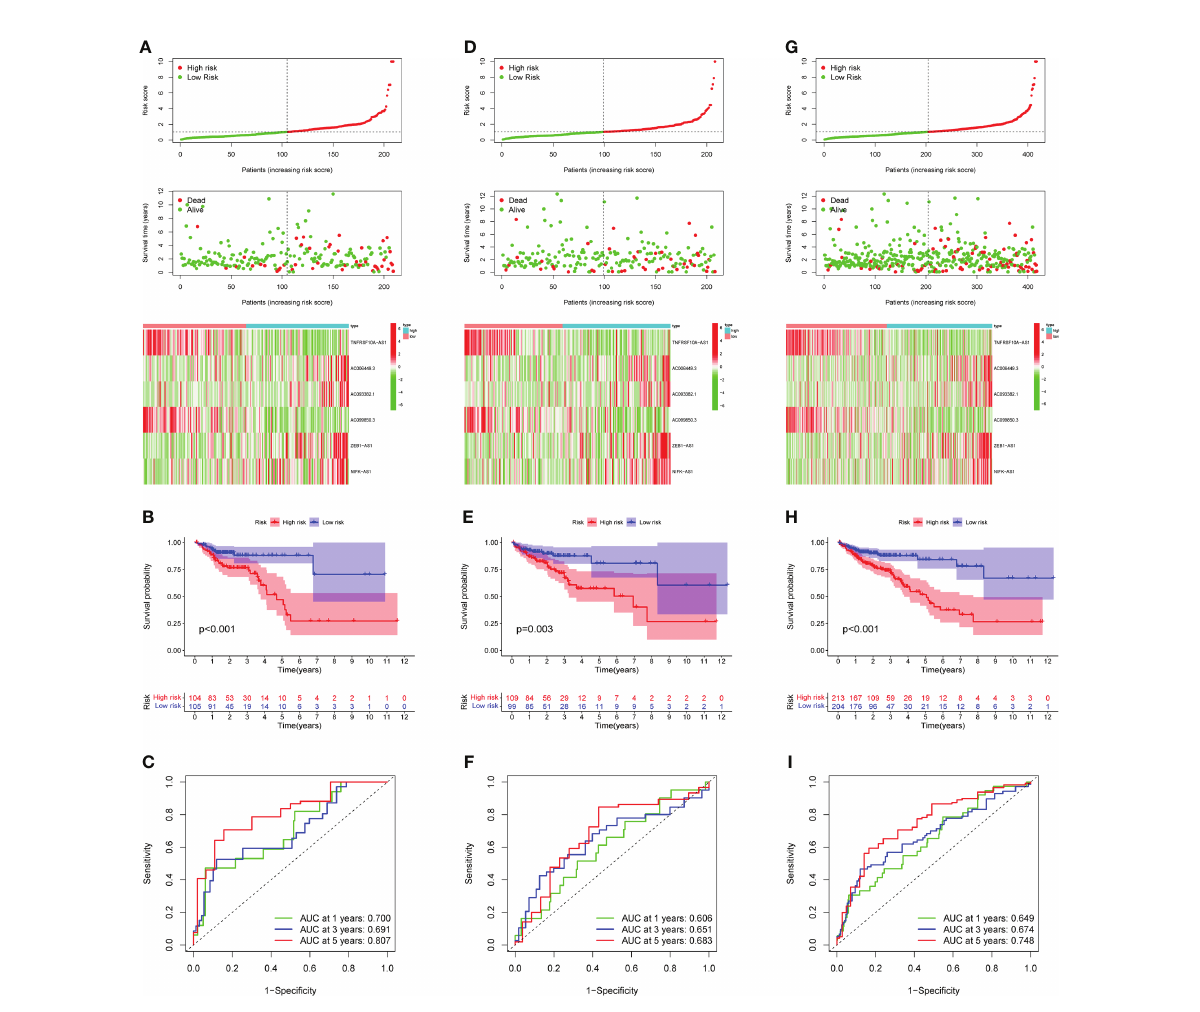
FIGURE 3 Prognostic model construction and evaluation. (A) In the training cohort, the patient with different risk score, survival status, and CRLs expression were shown. (B) Survival analysis of training cohort and the prognosis of high-risk group was signi fi cantly worse. (C) ROC curve revealed that in the training cohort, the AUC values for 1, 3, and 5-years OS were 0.700, 0.691, and 0.807, respectively. (D, G) In the testing and entire cohort, the patient ’ s risk score, survival status, and CRLs expression were shown. (E) The high-risk group ’ s prognosis in the testing cohort was also signi fi cantly worse. (F) In the testing cohort, AUC values of 1, 3, and 5-year OS were 0.606, 0.651, and 0.683, respectively, according to the ROC curve. (H) In the entire cohort, survival analysis revealed worse outcomes in the high-risk group. (I) In the entire cohort, the AUC values of the model in 1, 3, and 5-years OS were 0.649, 0.674 and 0.748,